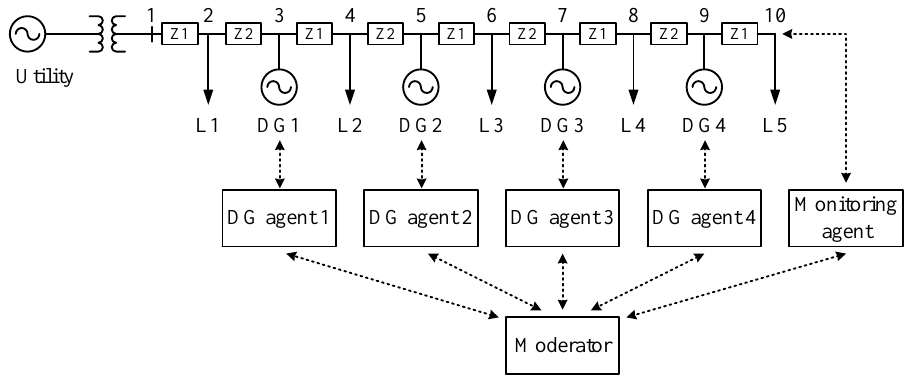
Figure 7. The test system to simulate the voltage control method.